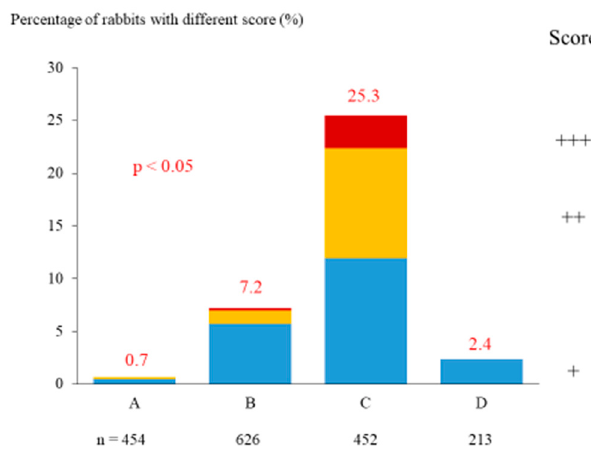
Figure 8. Influence of floor design on frequency of wounded rabbits at the end of the growing period.